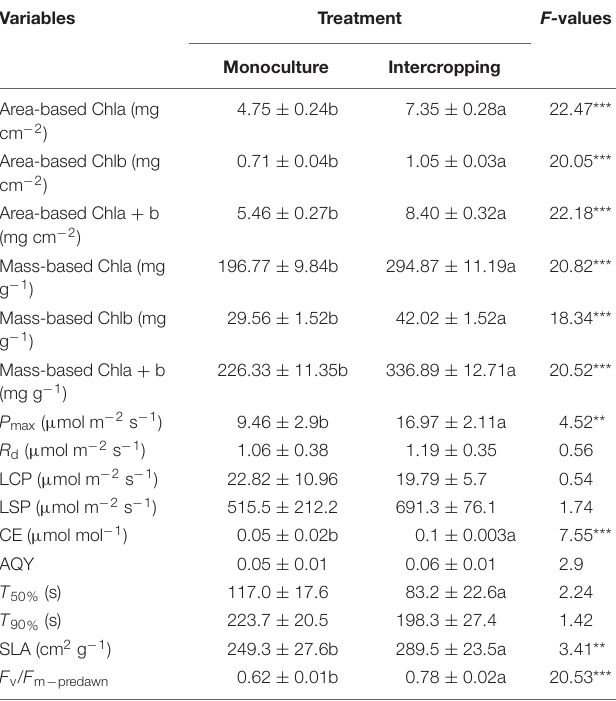
TABLE 1 | Photosynthetic-related characteristics in the leaves of A. xiei under different cropping systems (Data are means ± SD, n = 5–10). Variables Treatment F- values